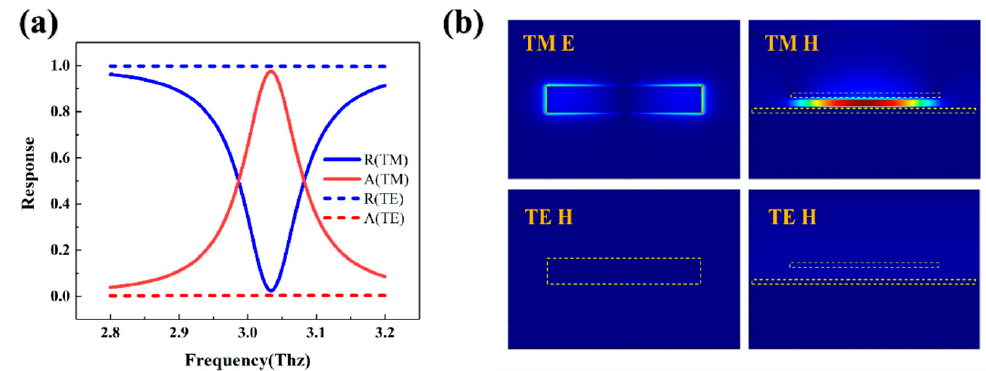
Figure 4. ( a ) Response spectrum (absorption and reflectance) of TM and TE polarized light. ( b ) Electric and magnetic field distribution at the absorption peak (electric field at the top structure in the xy plane and magnetic field in the xz cross section).